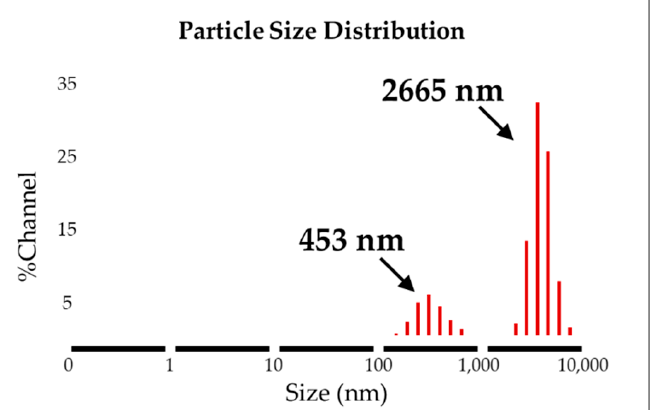
Figure 5. Dynamic light scattering analysis of SMWs (solvent: distilled water).